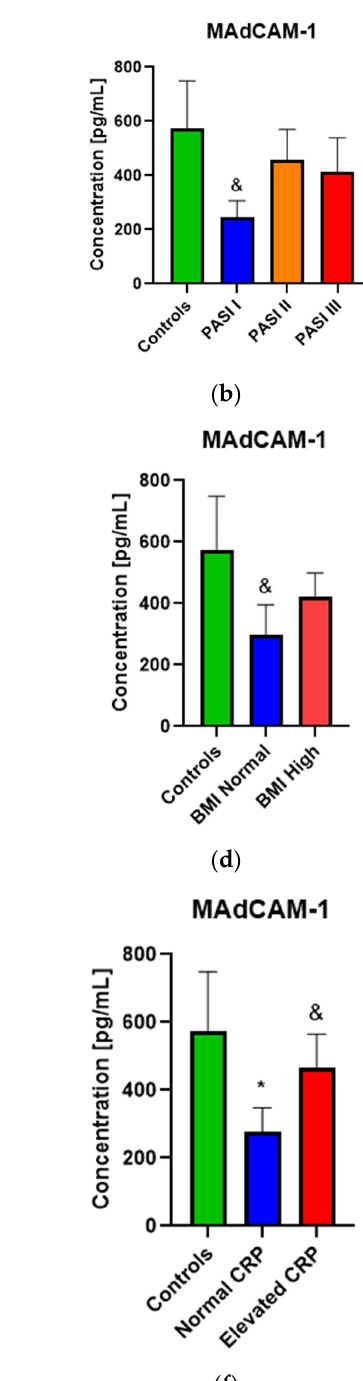
Figure 2. The levels of ITGB7 and MadCAM-1 in terms of PASI scoring, & means the existence of a trend between controls and PASI I subpopulation. p = 0.12 ( a , b ), BMI, & means the existence of a trend between controls and PASI I subpopulation. p = 0.11 ( c , d ), and CRP, * means p < 0.05 when comparing controls to normal CRP subgroup. p = 0.035, & means the existence of a trend between normal and elevated CRP subpopulation. p = 0.066 ( e , f ) allocations in psoriatic patients subgroups. PASI, psoriasis area and severity index; CRP, C-reactive protein; BMI, body mass index. The assessment of relationships between the proteins and various laboratory parame- ters was performed and the most relevant data are listed in the Table